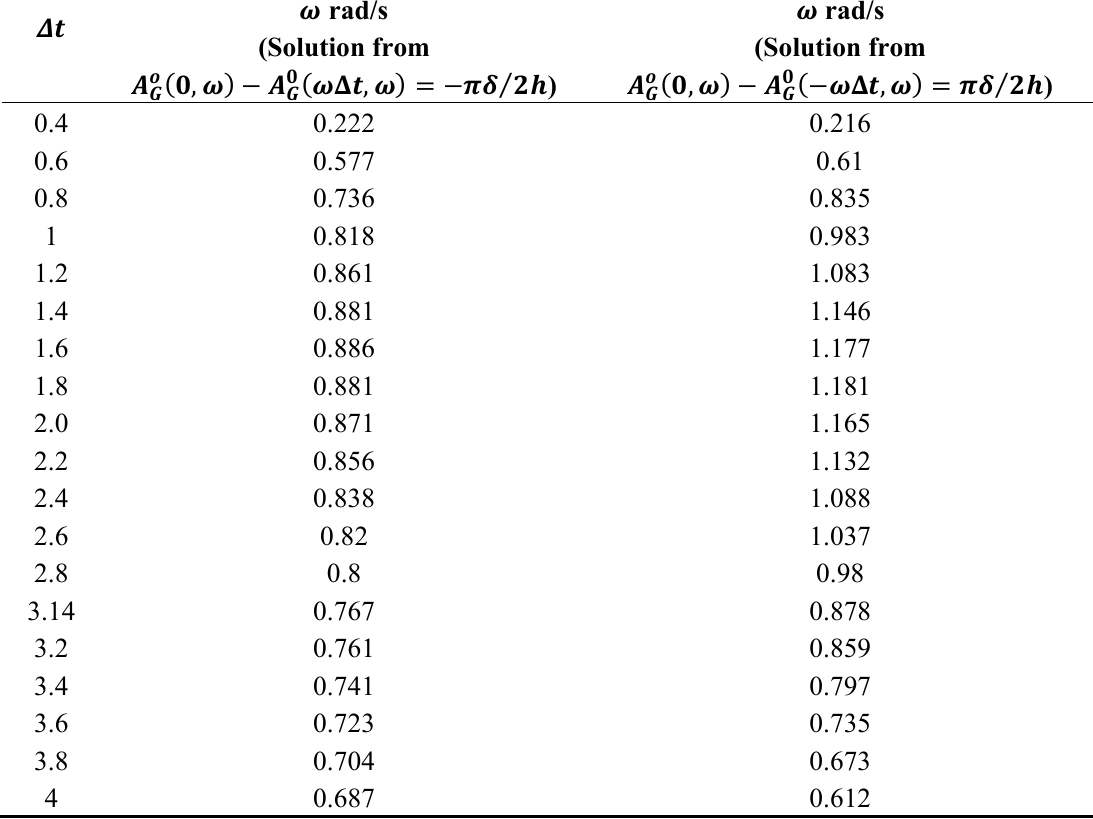
Table 4. Recorded values of